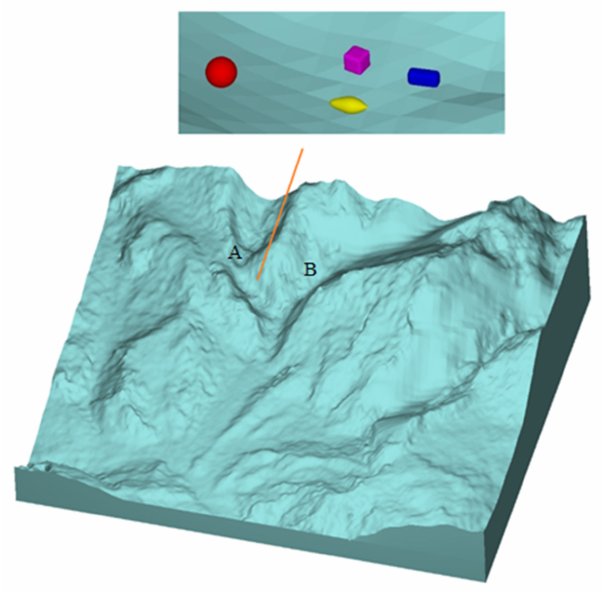
Figure 4. Digital elevation model (DEM) of the Zhouqu debris